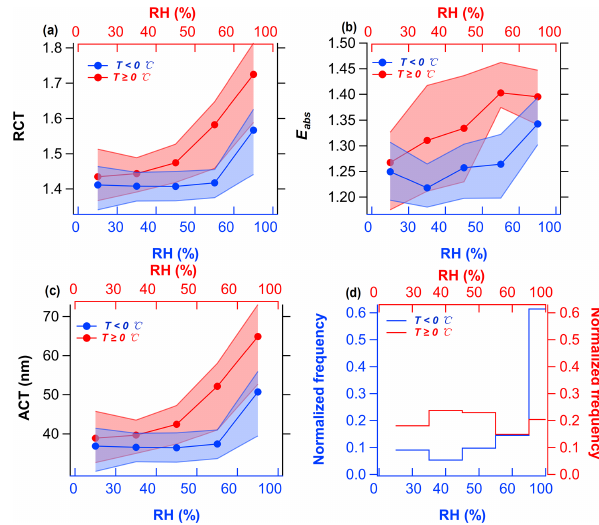
Figure 9. (a–c) RCT ( D c @180nm), E abs , and ACT ( D c @180nm) dependence on RH under the temperature regimes of − 14 ◦ C < T < 0 ◦ C and 0 ◦ C < T < 8 ◦ C. Circles represent the average val- ues. The upper and lower boundaries of the shaded areas represent the 75th and 25th percentiles of data points in each bin. (d) The nor- malized frequency of data points in each bin under different temper- ature ranges.